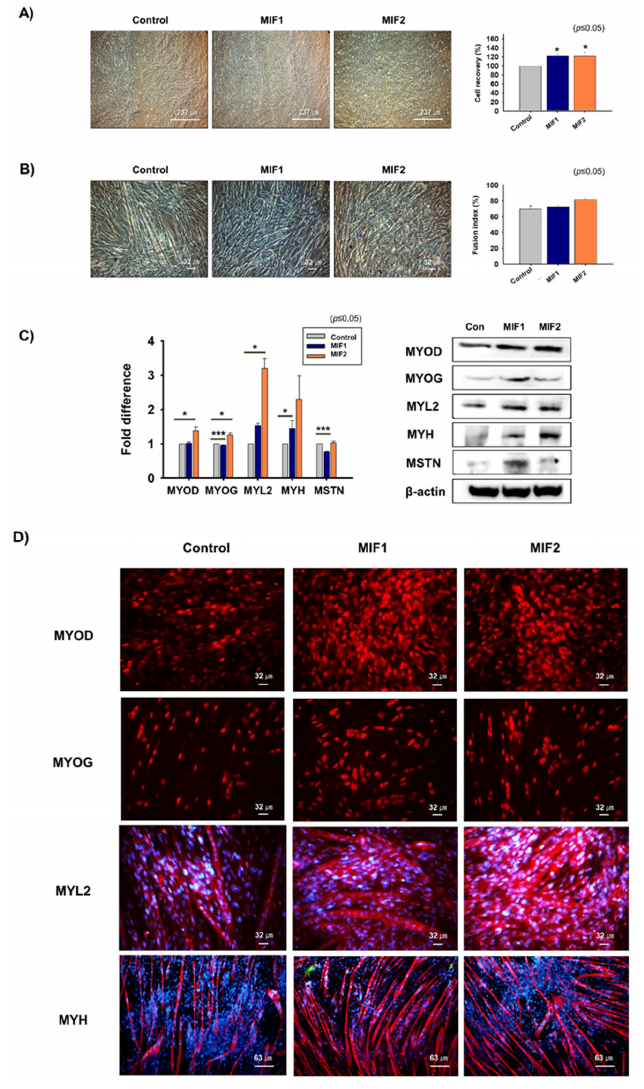
Figure 3. Myoblast proliferation and differentiation in the presence of non-modified MIF 1 and 2 peptides. ( A ) When C2C12 cells reached 100% confluence, cell layers were scratched and incubated with MIF1 or MIF2 for 1 day. Cell proliferation was analyzed using an MTT assay. ( B – D ) When cells had reached 70% confluence, growth medium was switched to differentiation medium containing MIF1 or MIF2 and cells were incubated for 3 days. Myotube formation was observed and fusion indices determined by Giemsa staining. mRNA and protein expression of MYOD, MYOG, MYL2, MYH, and MSTN were determined by real-time RT-PCR and Western blot, respectively. Protein localizations were determined by immunocytochemistry. Non-treated cells were used as controls. Means ± SD (n ≤ 3). * p ≤ 0.05, ** p ≤ 0.001, *** p ≤ 0.0001.